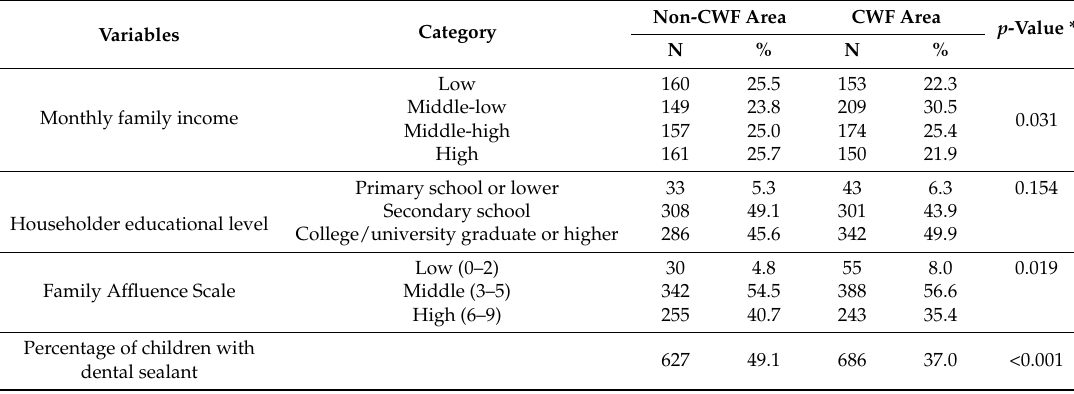
Table 3. Decayed, missing, and filled teeth (DMFT), decayed, missing, and filled tooth surfaces (DMFS), pit-and-fissure DMFS, and smooth surface DMFS scores adjusted for confounding factors.